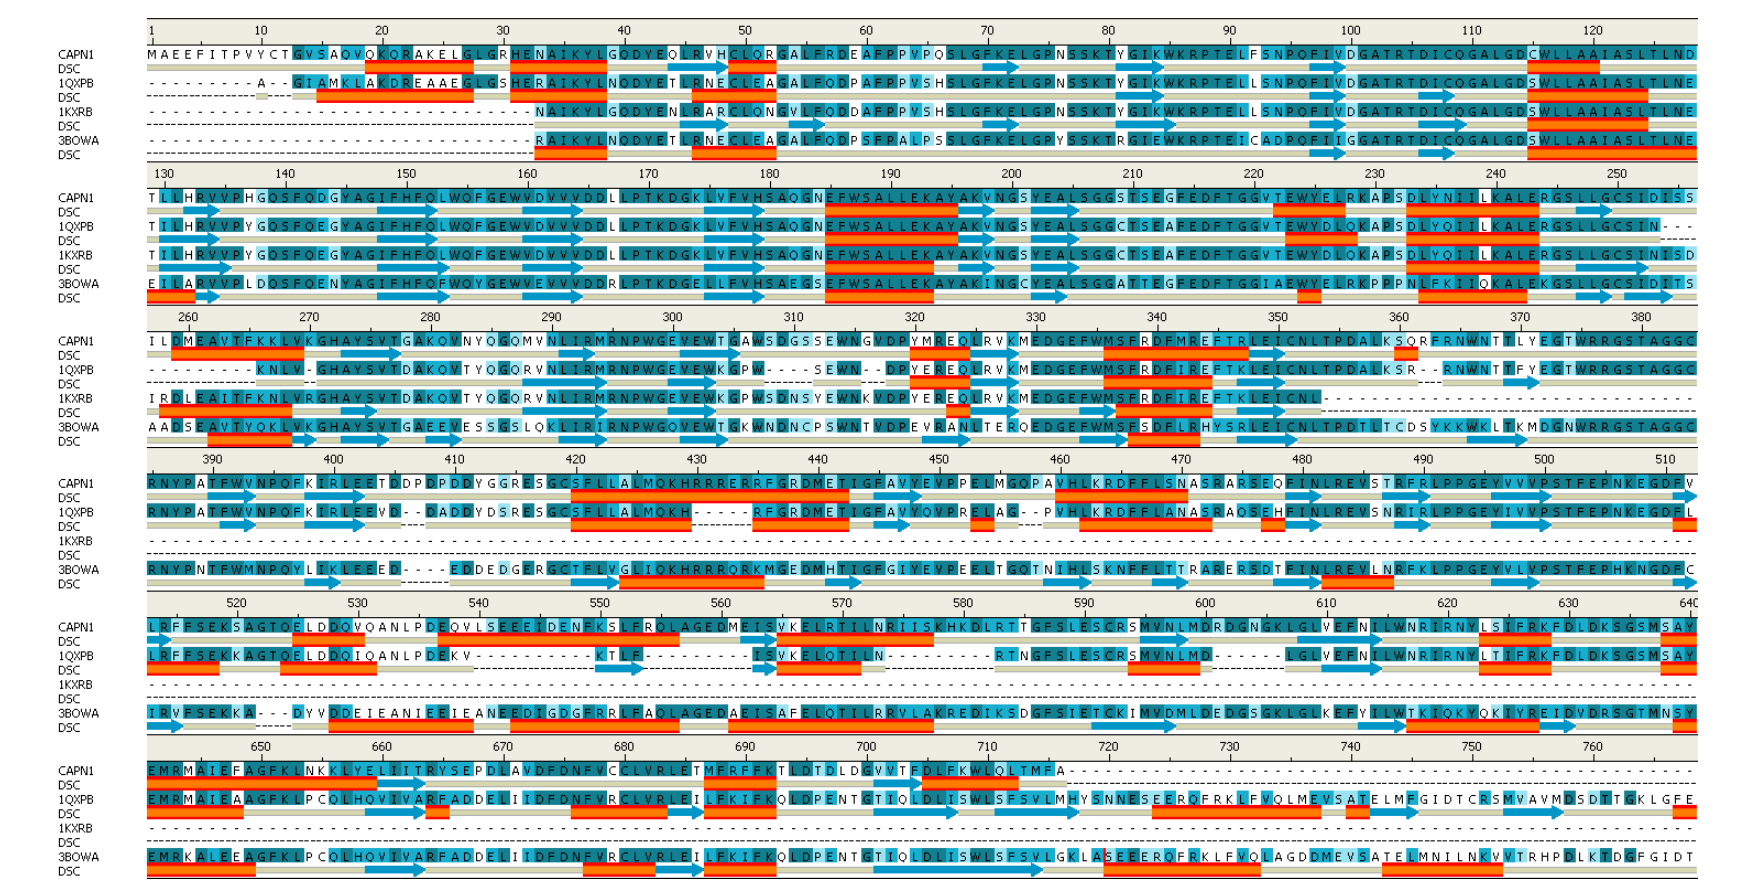
Figure 11. Sequence alignment between the bovine CAPN1 and templates (identity: 59.4%–80.2%; similarity: 77.0%–82.4% with templates (1QXP:B, 1KXR:B, and 3BOW:A) and secondary structures(alpha helices: red bars; beta strands: blue arrows; coil: beige bar) based on sequence